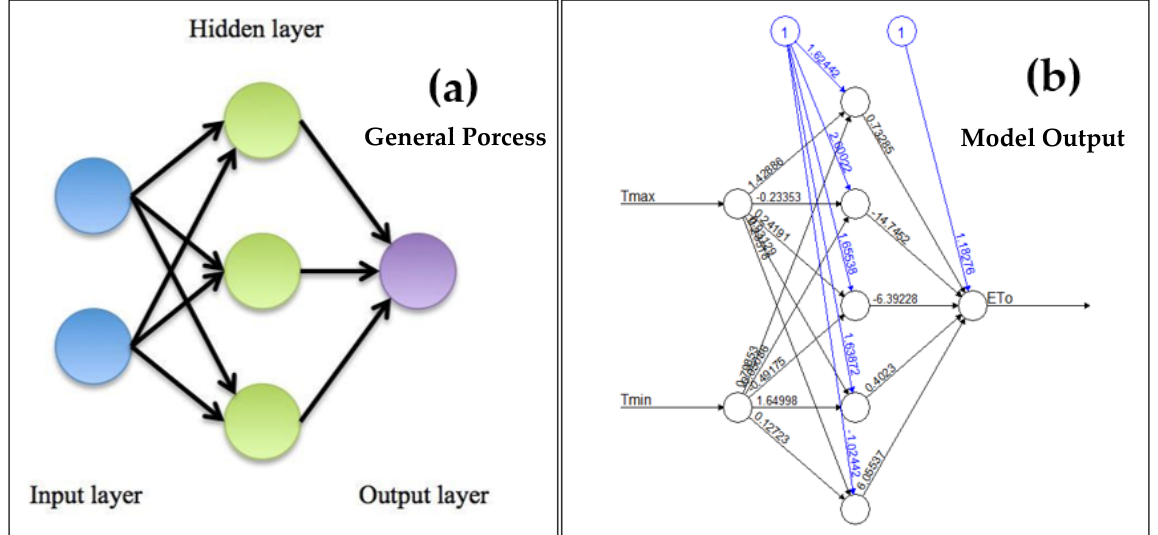
Figure 4. Schematic structure of the neural network (NN)-based ML models in ET o modeling.